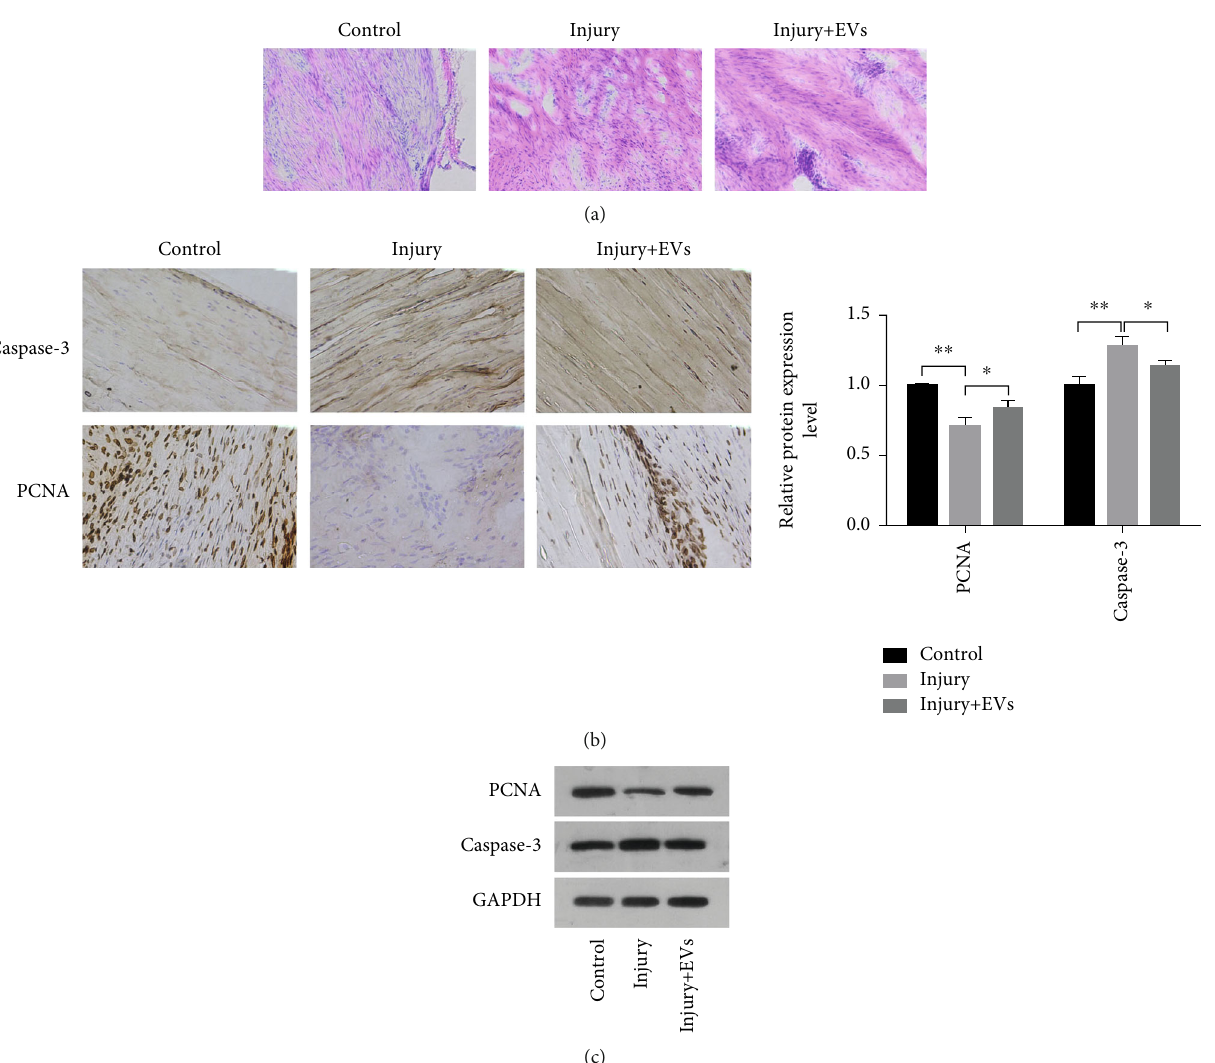
Figure 7: EVs rescued the tendon repair through promoting proliferation of tendon cells. (a) HE staining was used to detect tendon tissue. Base magni fi cation: × 200. (b) Immunohistochemistry was performed to detect the expression of both PCNA and Caspase-3 in the tendon tissue. Base magni fi cation: × 400. (c) The expression of apoptosis-related proteins was detected by Western blot in the control group, injury group, and injury+EV group ( ∗ P < 0 : 05 , ∗∗ P < 0 : 01